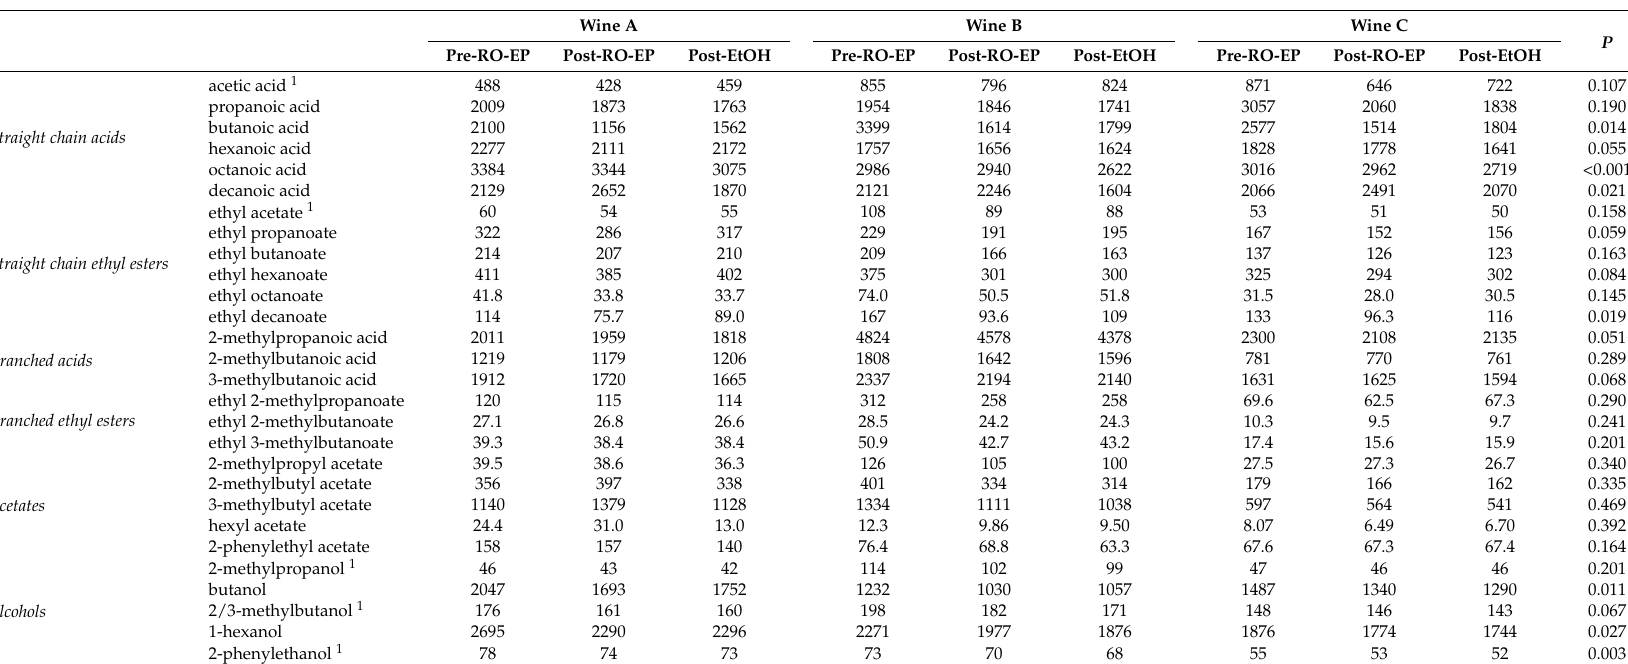
Table 2. Concentrations of fermentation volatiles present in Trial 1 wines before and after RO-EP treatment, and following RO-EP treatment and alcohol